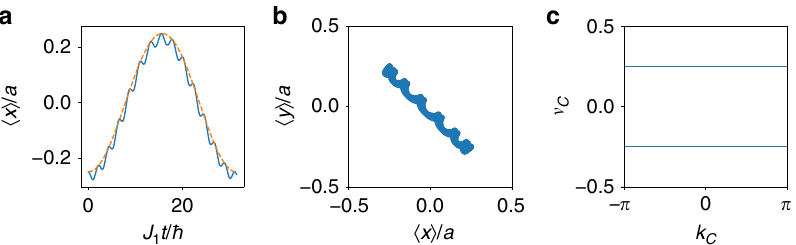
Fig. 3 Single-plaquette dynamics. a Comparison between (solid line) the exact dynamics and (dashed line) the projected model. b Full real-space evolution. c Hybrid Wannier centers obtained from diagonalizing the Wilson loops orthogonal to the C path away from the atomic limit for J 1 = 0.3 J 2 . Here the force is aligned along the diagonal F x = F